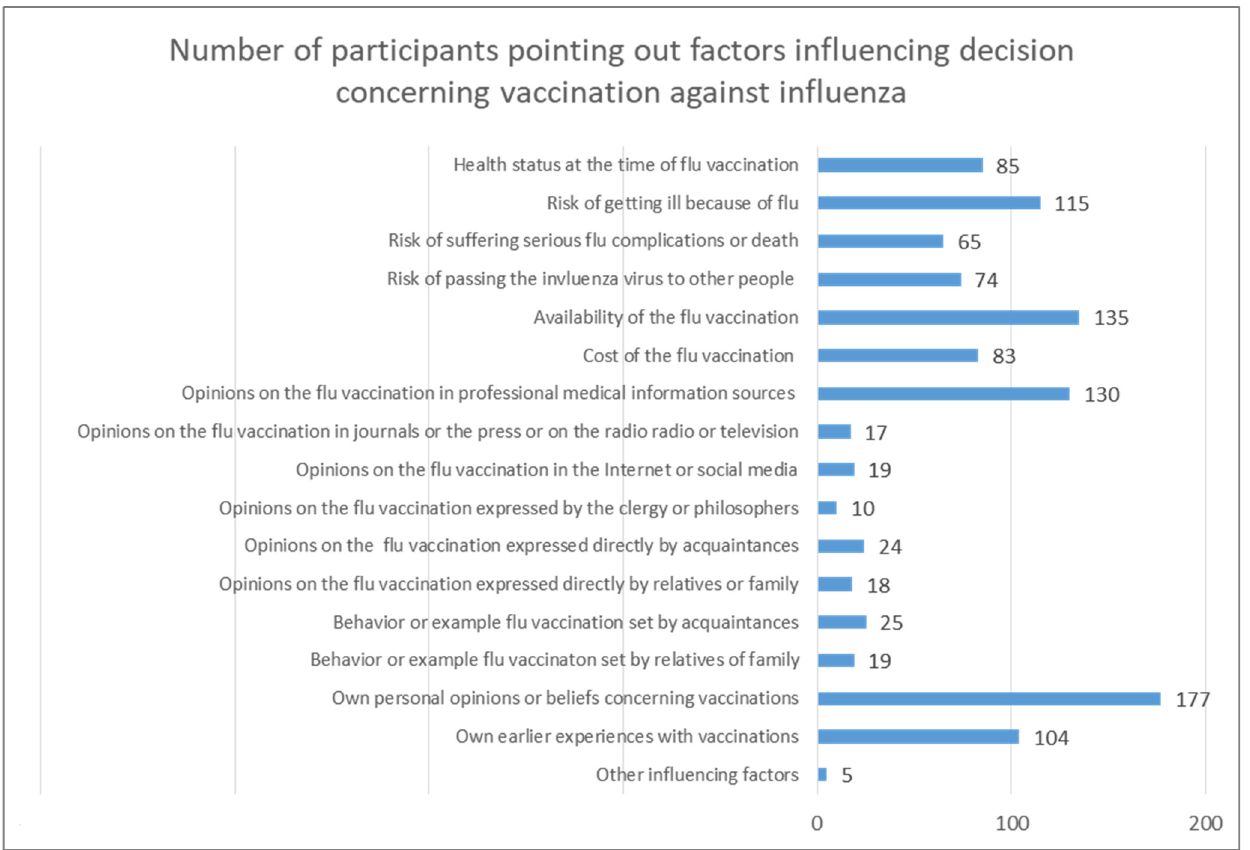
Figure 2. Number of participants pointing out factors influencing their decision concerning vaccina- tion against influenza.